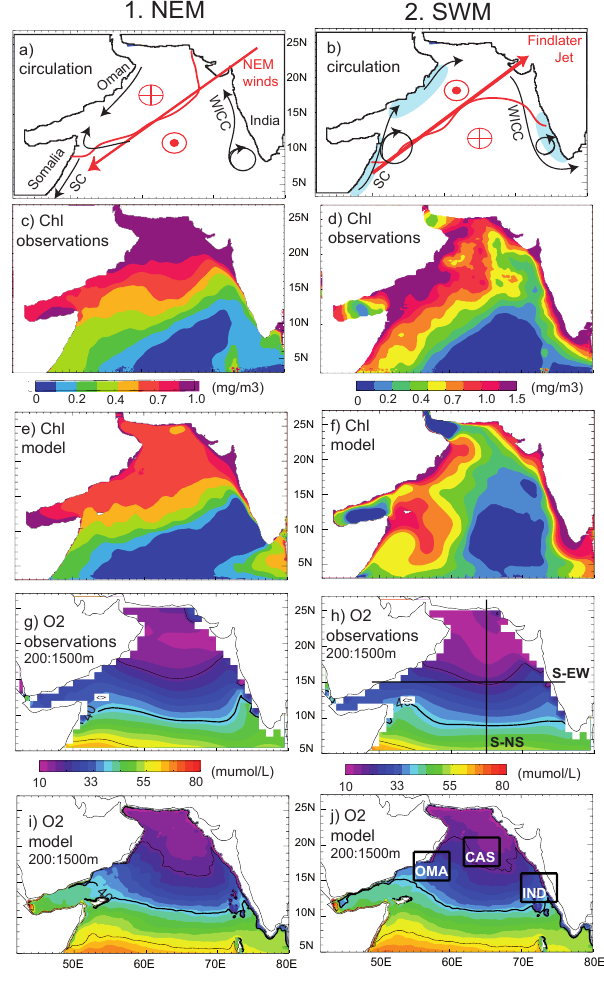
Fig. 1. Climatological maps during the northeast monsoon (NEM, December–February) and southeast monsoon (SWM, June– August): (a) , (b) Schematic representation of dominant winds (red arrows), oceanic circulation (black arrows), coastal upwelling sys- tems (blue shading) and Ekman pumping (red symbol) adapted from Schott and McCreary (2001). The reversing Somali Current (SC) and Western Indian Coastal Current (WICC) are indicated; (c– f) surface chlorophyll (Chl, in mgm − 3 ) climatology from satellite SeaWiFS (1998–2005) (c) , (d) and simulated in the model (e) , (f) ; (g–j) oxygen concentration averaged between 200 and 1500m in WOA09 (g) , (h) and simulated in the model (i) , (j) . Sections EW and NS presented in Figs. 4 and 5 are indicated in (h) . Regions CAS, OMA and IND presented in Figs. 6–8 are indicated in (j)